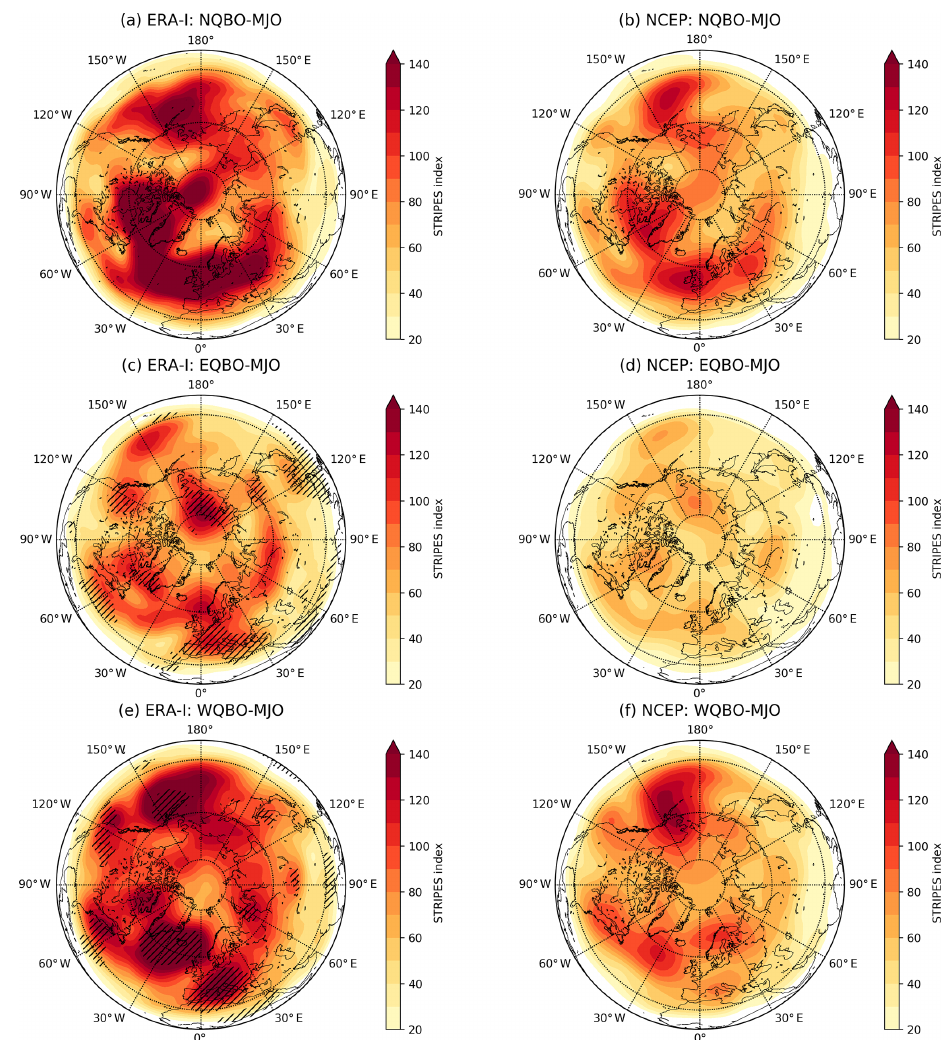
Figure 3. STRIPES values for (a, c, e) ERA-Interim and (b, d, f) NCEP for all (a, b) NQBO–MJO, (c, d) EQBO–MJO, and (e, f) WQBO– MJO events. (a, c, e) Black hatching denotes STRIPES values that are statistically larger than expected by chance at 90% confidence in ERA-I. Significance is only calculated for